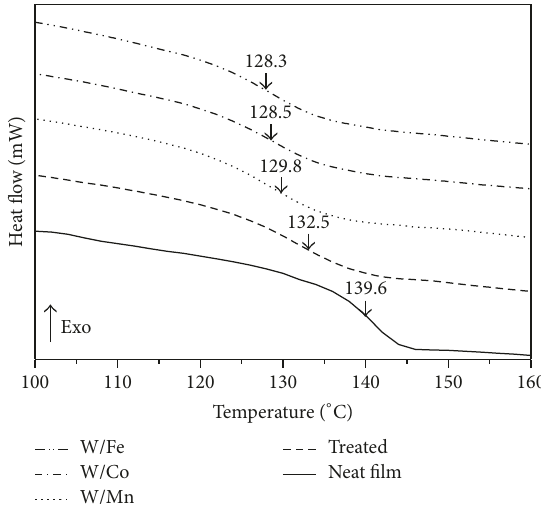
Figure 19: DSC traces of the Topas COC 6013 neat and formulated films with POA after 30 days of aging under photoirradiation.